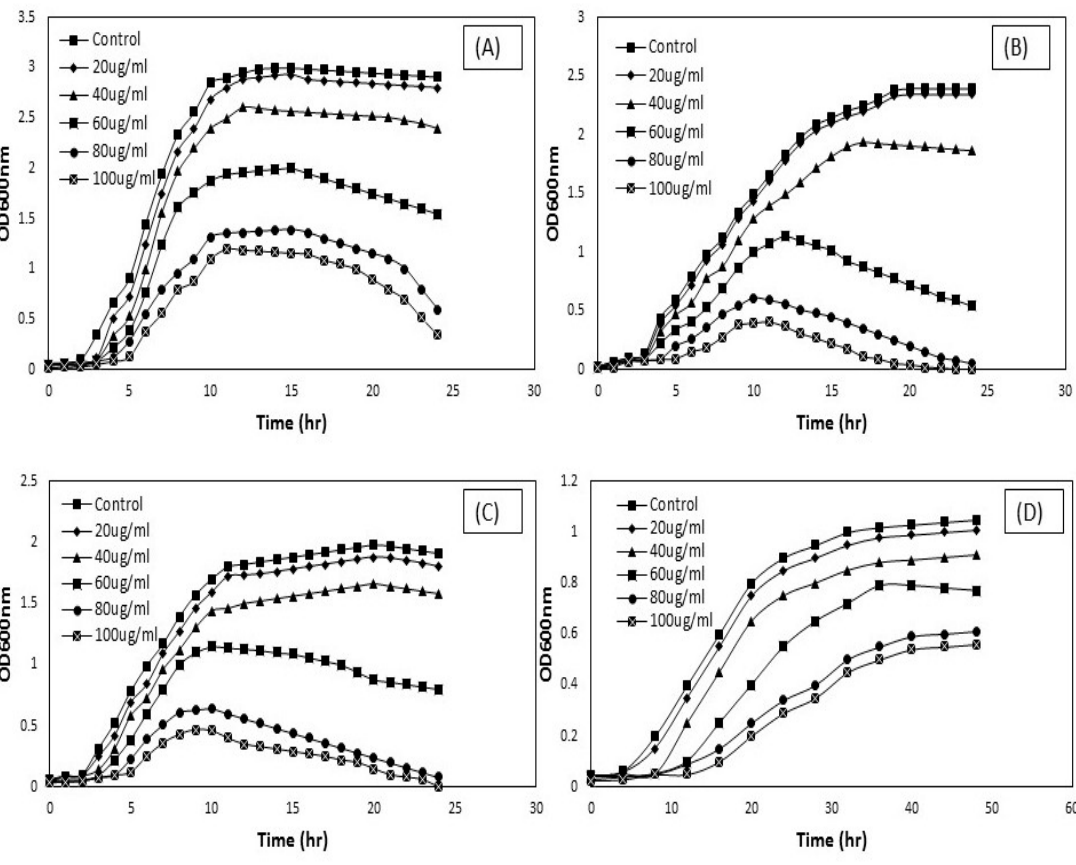
Figure 6. OD growth curves attained when 150 µL of ~10 7 –10 8 CFU/mL Staphylococcus aureus ( A ), Pseudomonas aeruginosa ( B ), Klebsiella pneumoniae ( C ), and Candida albican ( D ), treated with MWCNTs at the following conditions and then grown in 5 mL of LB and YPD broth at 37 °C: treated with desired concentration of 20, 40, 60, 80, and 100 µg/mL MWCNTs in DI water for 1 h. The cell suspension was used as a control sample in DI water.